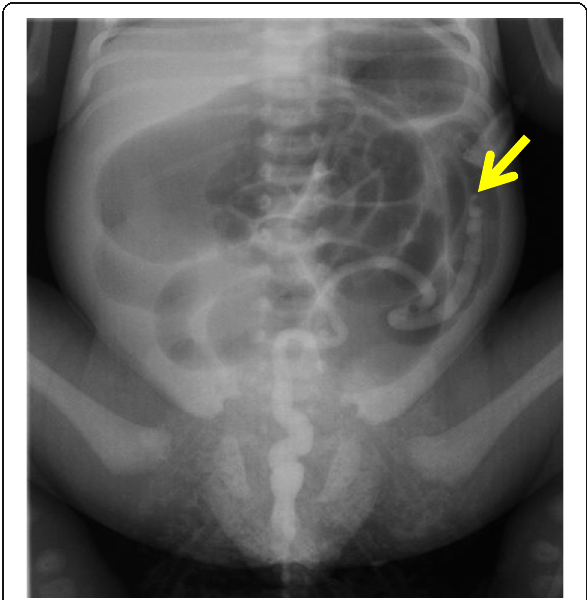
Fig. 2 Contrast enema examination (3 days of age). The arrow showed a microcolon and disruption in the descending